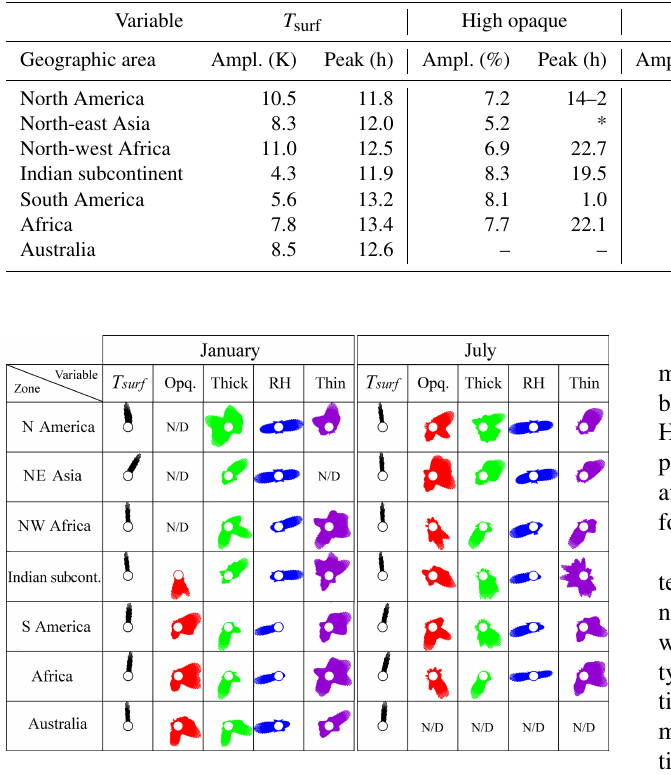
Figure 9. Circular histograms of local time of peak amplitude for T surf , high opaque clouds, thick cirrus, relative humidity (RH), and thin cirrus for January and July averages. The convention for vec- tor direction representation is consistent with that described in the caption of Fig. 6 while the amplitude is proportional to normalized histogram count number. “N/D” marks the cases for which the